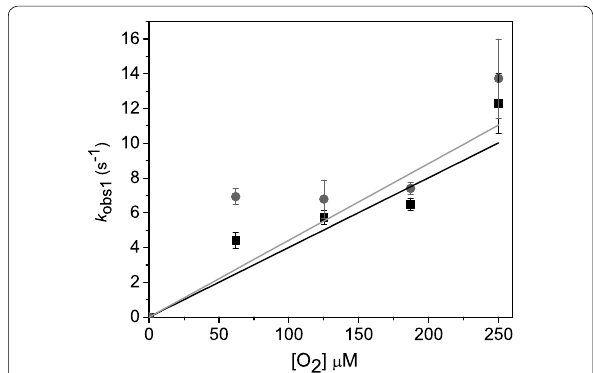
Fig. 8 The dependence of the k obs1 measured at 366 nm on [O 2 ]. The observed rate constants were plotted as a function of [O 2 ] in the absence (closed squares) and presence of 200 μM butanone (closed circles) for GSTACMO. The slope of the lines were used to determine the bimolecular rate constants ( k oo- and k oo-BT ) shown in Table